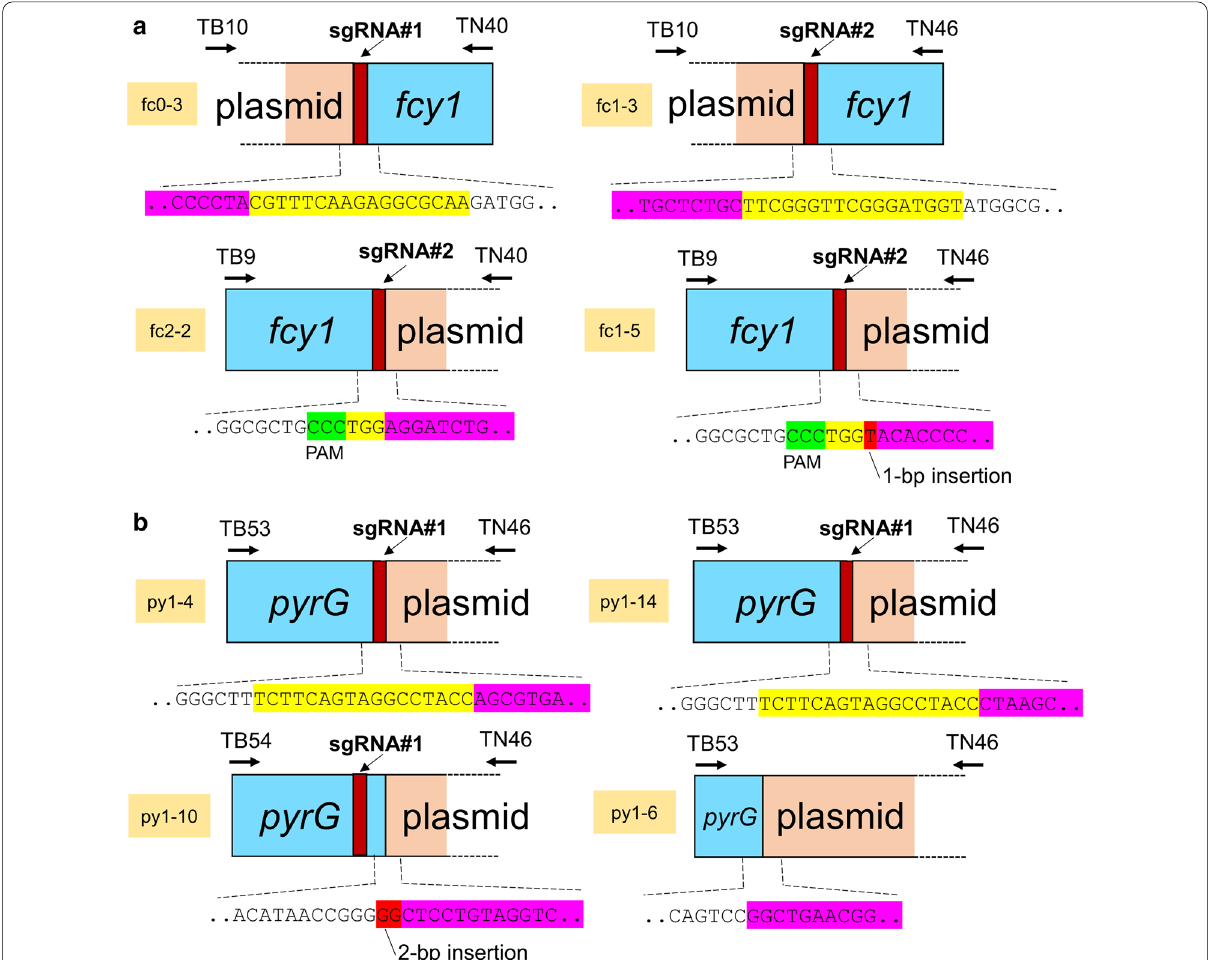
Fig. 3 Identification of insertional mutations in some fcy1 or pyrG mutants. Schematic diagrams showing how the introduced plasmids had been inserted at the target sites of fcy1 ( a ) or pyrG ( b ). For highlights in the nucleotide sequence: yellow shades indicate sgRNA, green shades indicate PAM sequence, pink shades indicate plasmid sequence, and red shades indicate